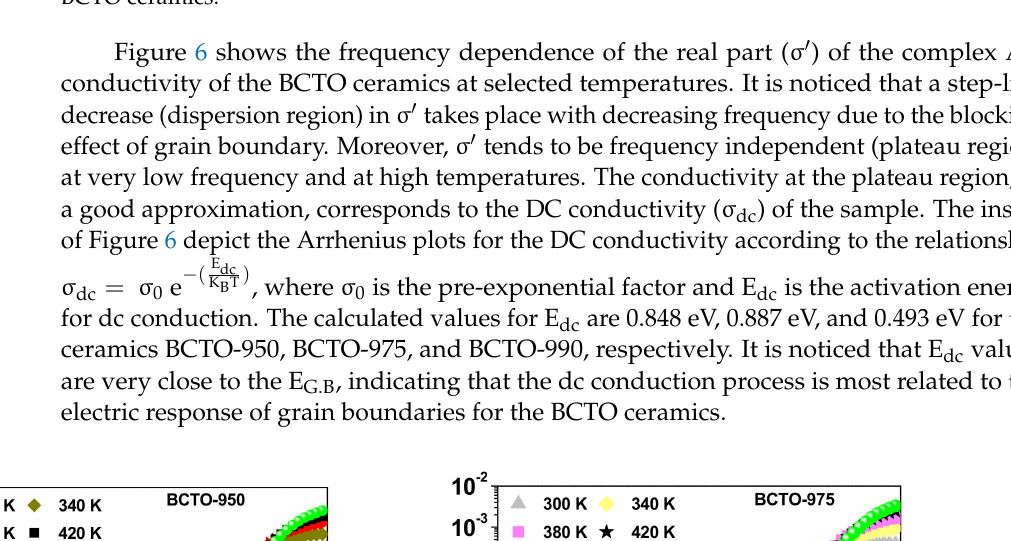
Figure 5. Arrhenius plots of the dc conductivity of grain (G.) and grain boundary (G.B.) for BCTO